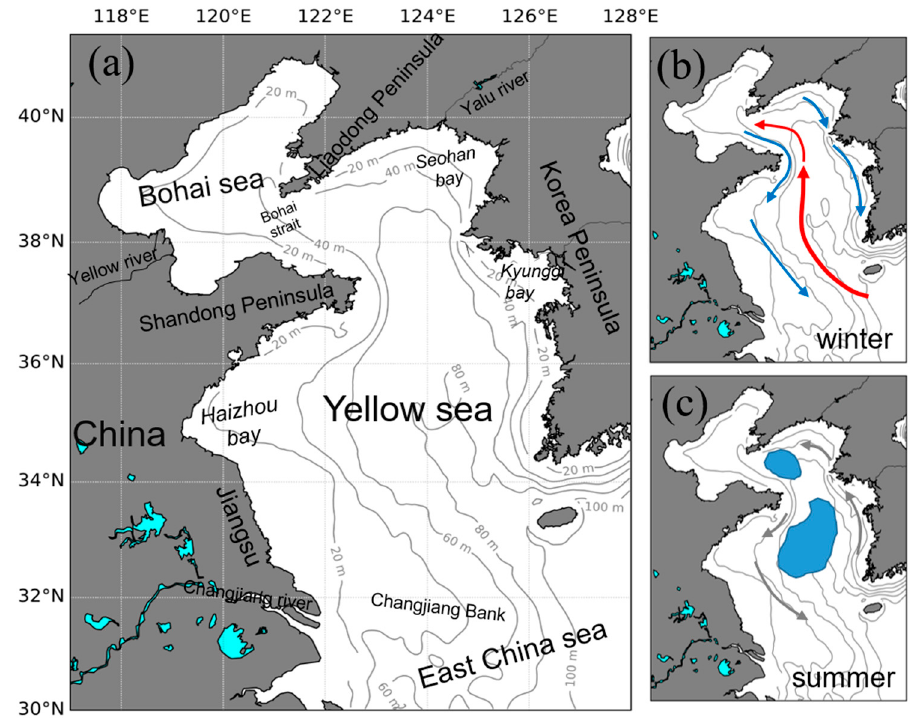
Figure 1. ( a ) Location and bathymetry of the Yellow and Bohai Seas. ( b ) Winter circulation pattern diagram, where red arrows and blue arrows represent the Yellow sea warm current and cold coastal currents, respectively. ( c ) Summer circulation (gray arrows) diagram, where the blue area represents the Yellow Sea cool water mass.